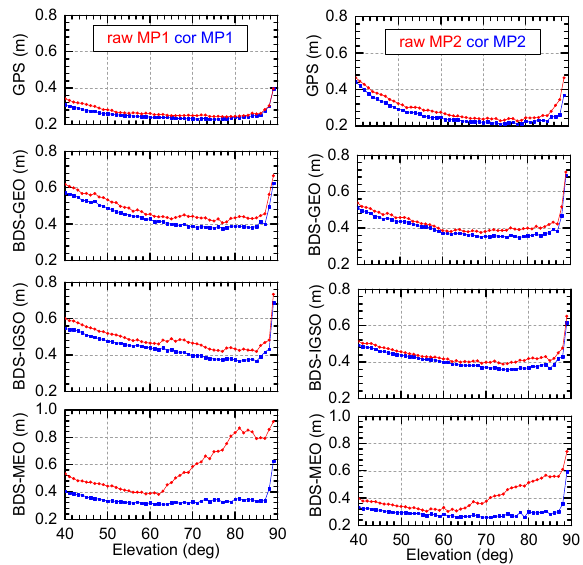
Figure 1. FY3C GPS/BDS multipath RMS values against satellite elevations. The elevation bin interval is 1°. The red dots in left panels represent the raw MP1 RMS (raw MP1) while the blue represent the MP1 RMS values with multipath grid map applied (cor MP1); the red and blue dots in right panels are the original MP2 RMS (raw MP2) and the grid model corrected MP2 RMS (cor MP2) values, respectively.